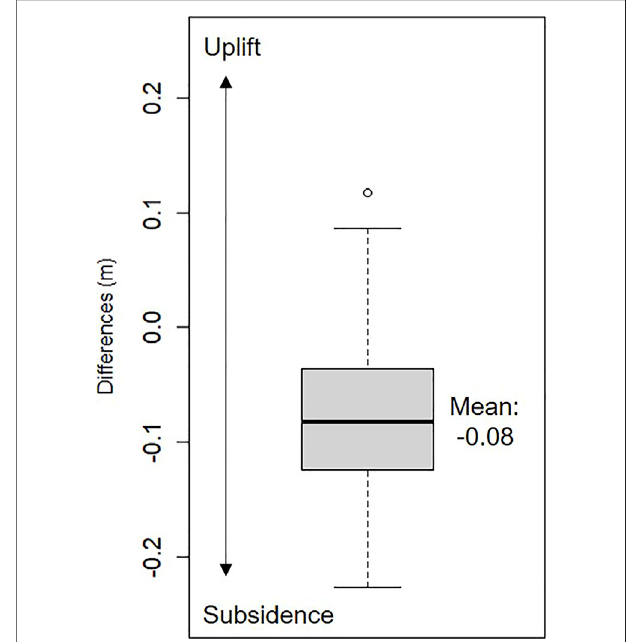
FIGURE 5 | (new). Box plot of elevation difference at the center part of polygons between 2016 and 2017 DSM.